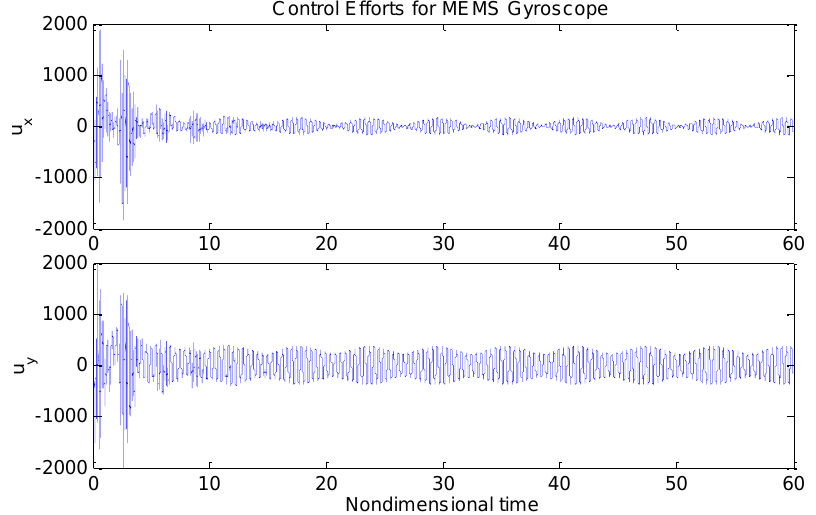
Figure 11. Control efforts for a microgyroscope using the adaptive controller in [2].